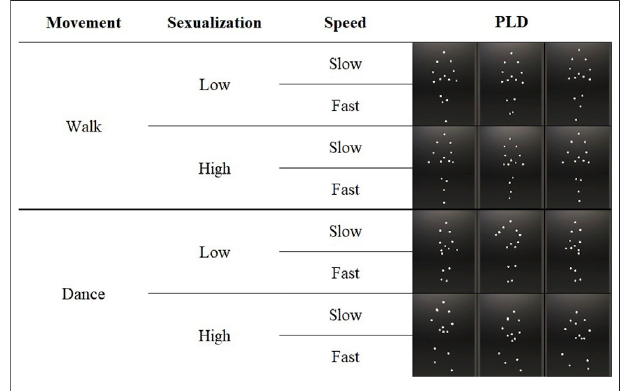
FIGURE 1 | Stimulus matrix for the PLD